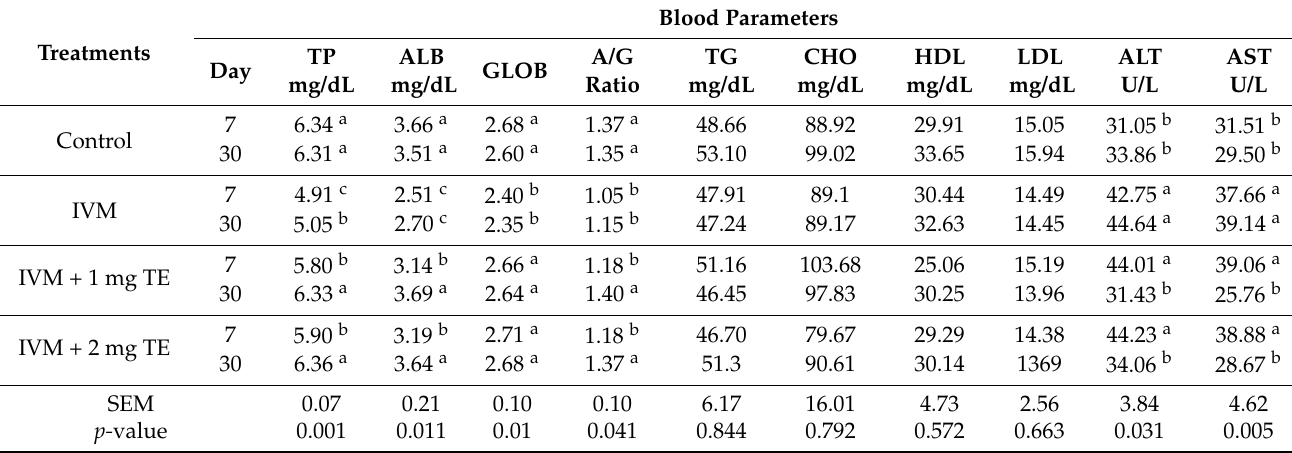
Table 5. The effect of combining Ivermectin injection with turmeric extract supplementation on the serum biochemical parameters.